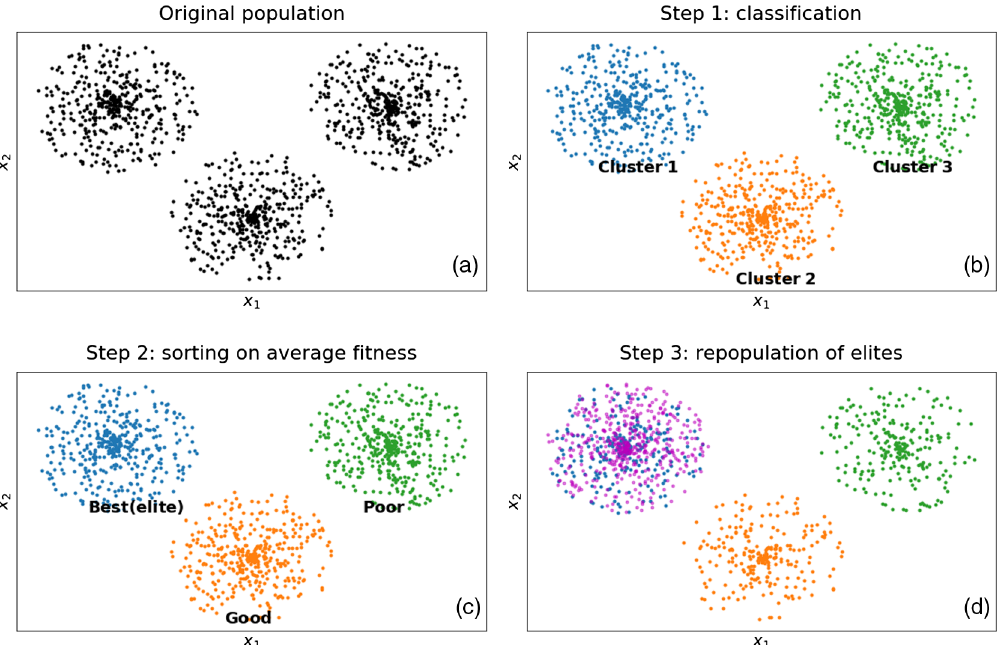
FIG. 1. Schematic illustration of intervention using machine learning techniques. Here, a search space of two free variables is assumed. The distribution of the original population is shown in the subplot (a). The candidates are classified into three colored clusters with the K-means algorithm in the subplot (b). The average fitness of each cluster has been evaluated, sorted, and given a status labeled with “ Best (elite), ” “ Good, ” and “ Poor ” respectively in the subplot (c). In the subplot (d), some potential competitive candidates (marked as the magenta dots) are repopulated inside the range of the “ Best (elite) ” cluster and then are used to replace the same amount of candidates from the original data pool. After the replacement, the post-population densities of the “ Good ” and the “ Poor ” cluster become low. In reality, there may not exist obvious boundaries to separate each cluster and cluster classification is not unique